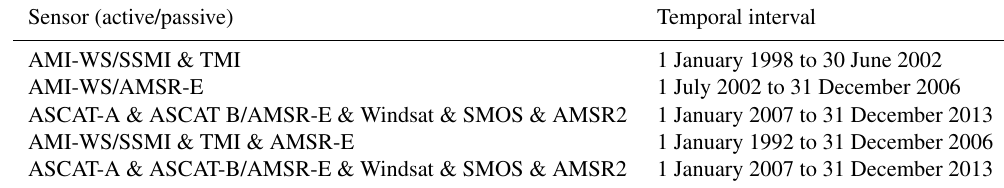
Table 1. Available sensors and temporal intervals considered for the SM2RAIN algorithm application.